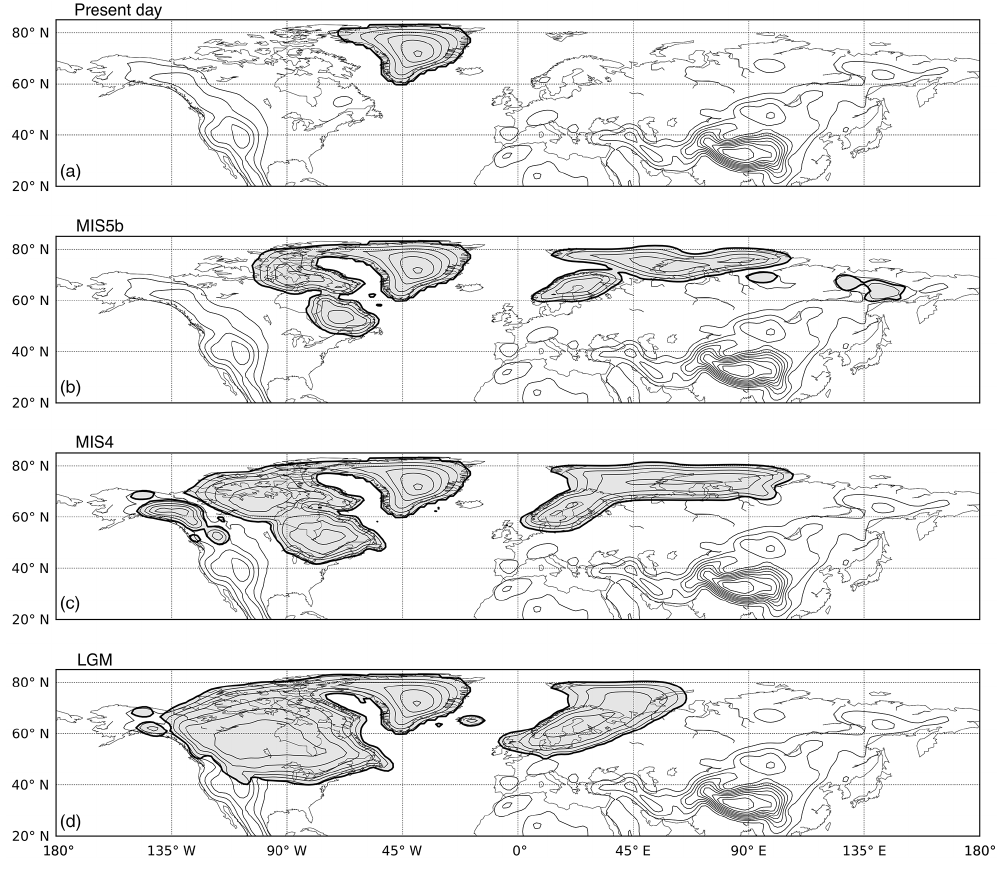
Figure 1. Northern Hemisphere topography representative of (a) present day and PI, (b) MIS5b, (c) MIS4, and (d) LGM, based on the ice-sheet reconstructions in Kleman et al. (2013). The shading represents ice sheets and the contour interval is 500m.